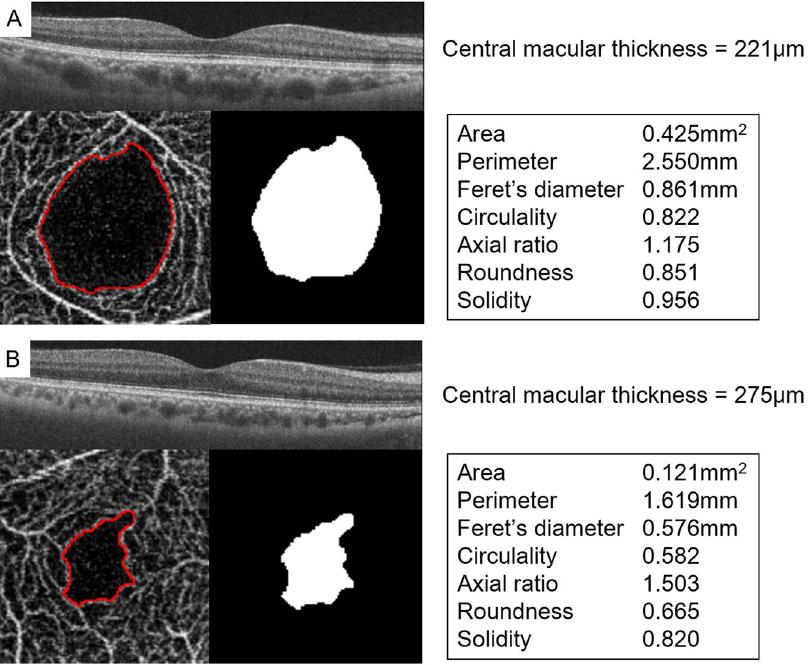
Figure 3. Characteristics of the shape of the FAZ in an eye with a thin fovea and an eye with a thick fovea. ( A ) Thin fovea had larger size of FAZ and circular-shaped FAZ. ( B ) Thick fovea had smaller size of FAZ and irregular-shaped